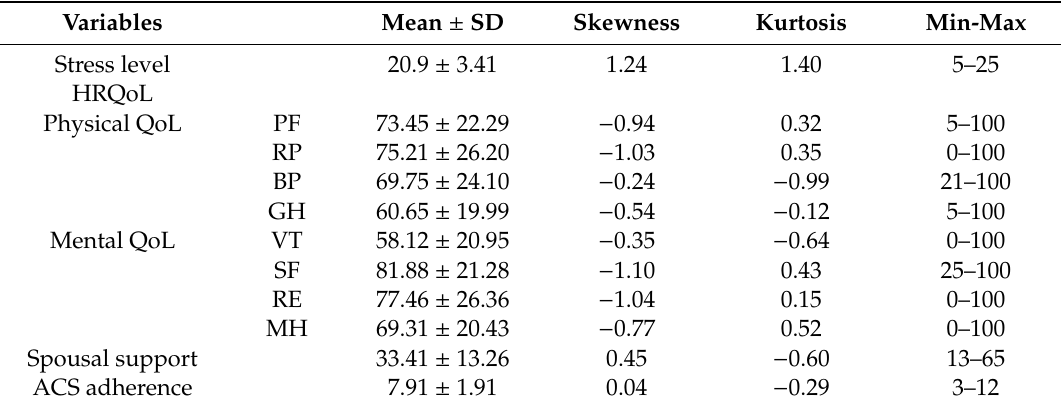
Table 2. Descriptive statistics of stress level, health-related quality of life, spousal support, and American Cancer Society (ACS) adherence ( n =